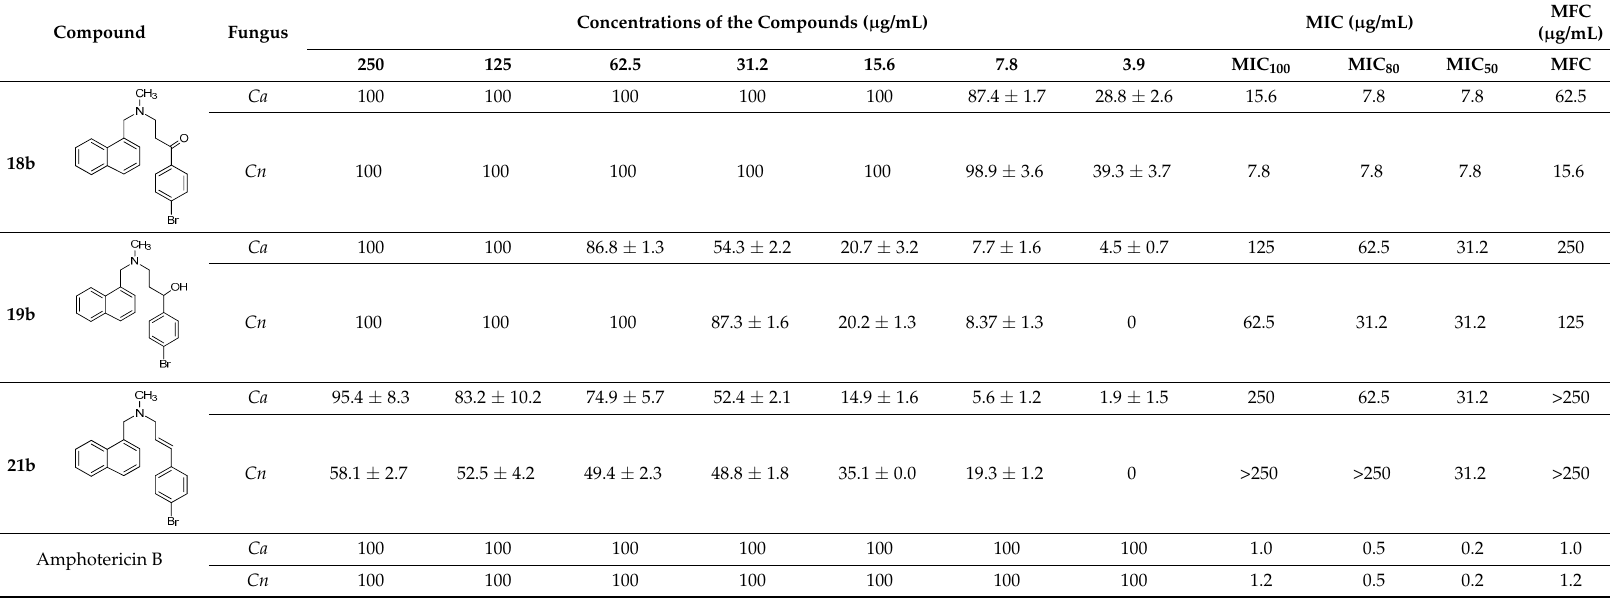
Table 2. The inhibition percentages values and Minimum Inhibitory Concentrations (MIC 100 , MIC 80 and MIC 50 ) and Minimum Fungicidal Concentration (MFC) of the naftifine-analogues 18b , 19b and 21b against C. albicans ( Ca ) and C. neoformans ( Cn ). Concentrations of the Compounds ( µ g/mL) Compound Fungus